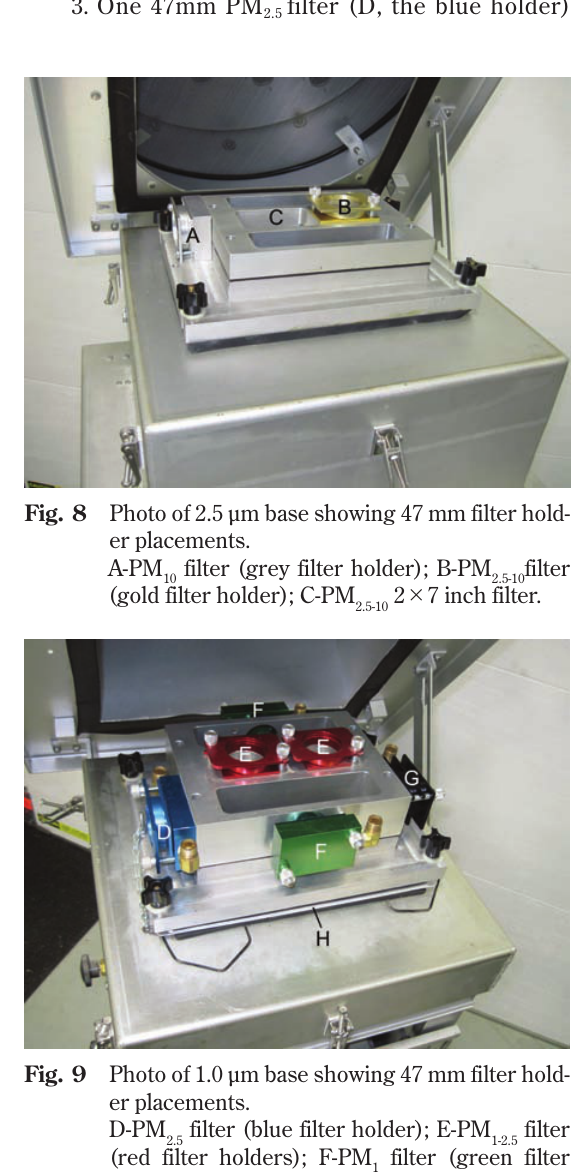
Fig. 10 Particle classification curves for 1.0 and 2.5